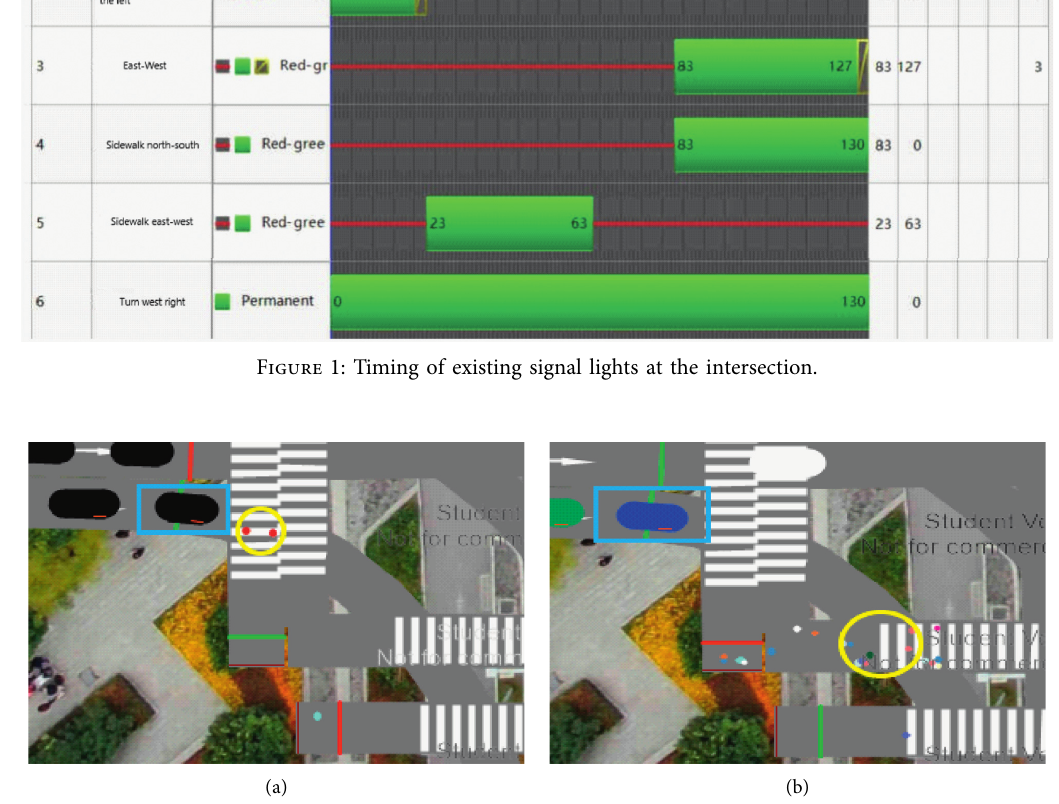
Figure 2: Collision between vehicles and pedestrians, the blue box represents a vehicle, the yellow box represents pedestrians. (a) The collision between a right-turning vehicle and a westbound pedestrian. (b) The collision between a right-turning vehicle and a southbound